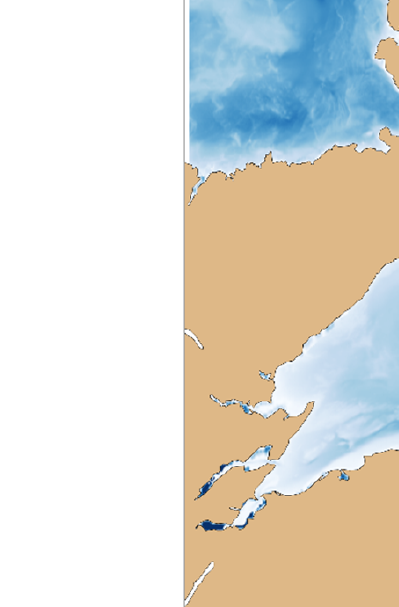
ERA-20C. It can be seen that peaks and troughs of the two datasets align well even though two datasets were retrieved for different coordinates. ERA-20C tends to model lower wave height, resulting in 1.82 m mean wave height compared to 1.95 m for ERA5. ERA5 mean wave height matches bet- ter with other sources for the same location, and with